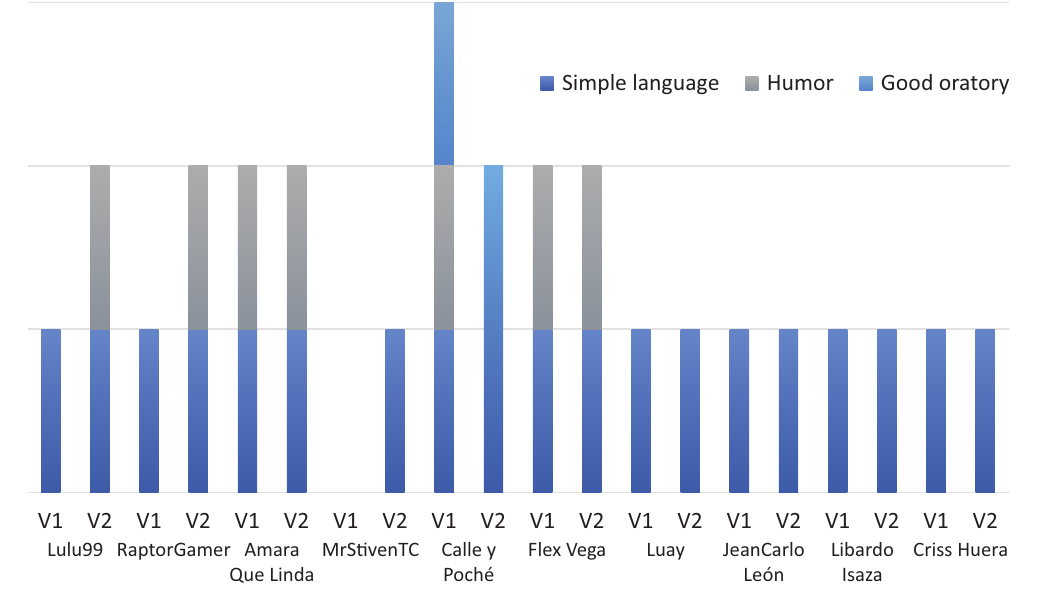
Figure 1. Discursive strategies used by YouTubers from the Andean Community. Media and Communication, 2022, Volume 10, Issue 1, Pages